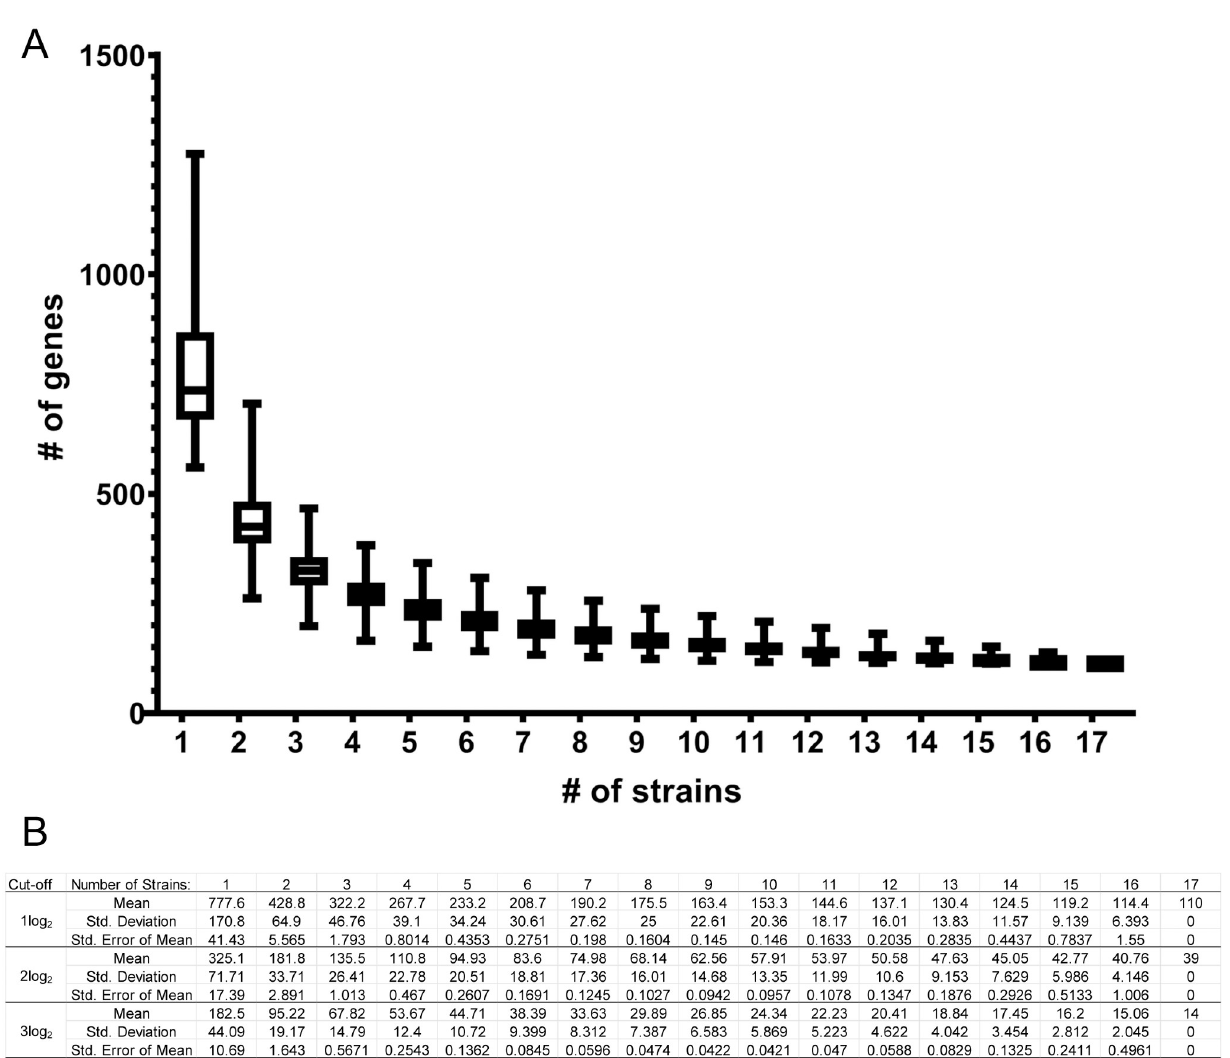
Fig 10. Size of EFG1 responsive gene set. Panel A. Regression showing the decay of the number of principal EFG1 -responsive genes with the addition of multiple strains. Each box plot represents all possible number of principal response genes (Y-axis) among a given number “n” of strains (X-axis). Panel B. Tabulation of mean number of Efg1-responsive genes as a function of number of strains tested with fold changes of 1 log 2 (as used throughout this study; described by y = 701.93x -0.656 and R 2 = 0.9894), or with higher thresholds of 2 log 2 (described by y = 310.83x -0.717 and R 2 = 0.9974) or 3 log 2 (described by y = 180.96x -0.844 and R 2 =